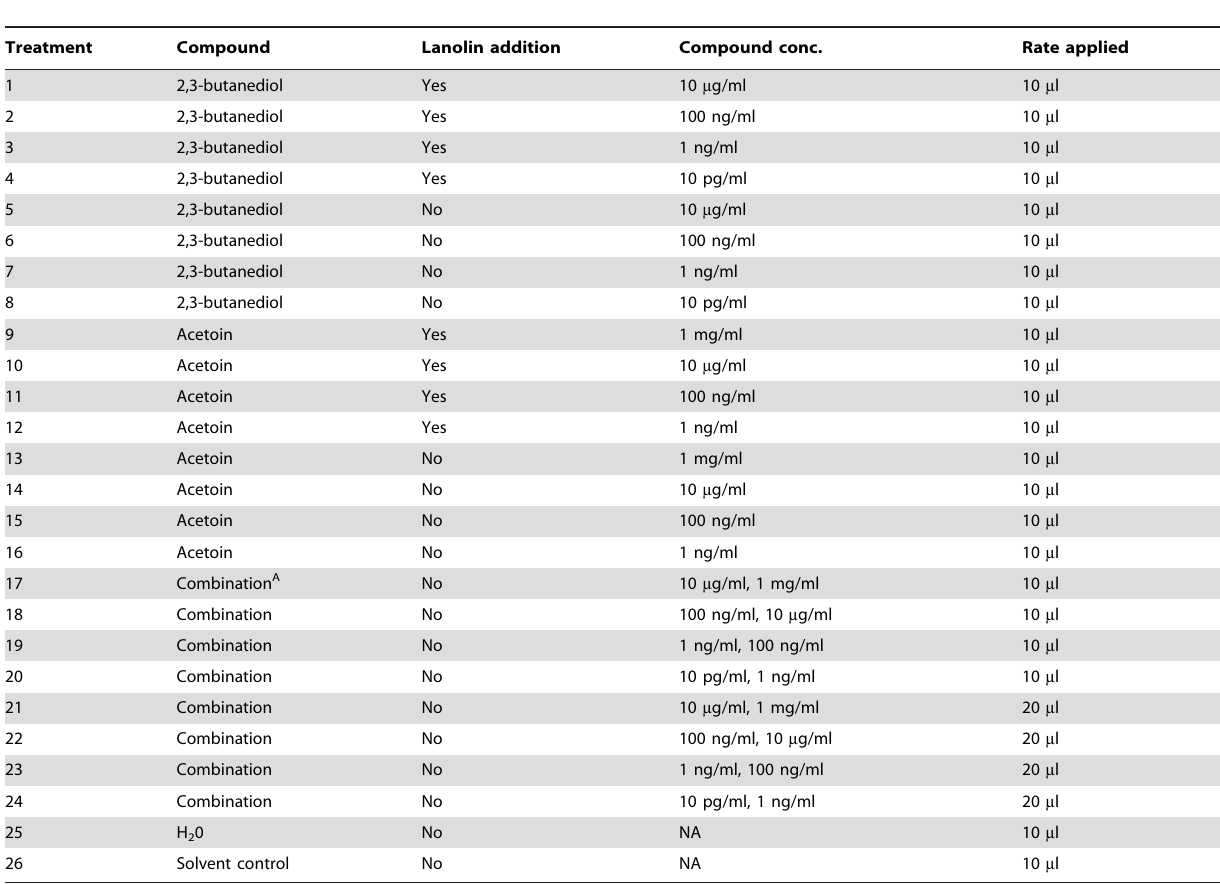
Table 4. Twenty-six treatments used to examine 3H2B (acetoin) and 23B (2, 3-butanediol) separately and in combination at various concentrations, in the presence or absence of lanolin, and at two application